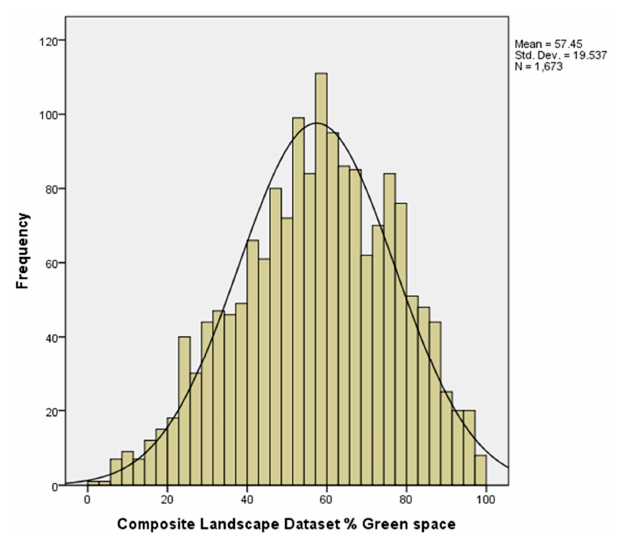
Figure 5. Frequency distribution of green space cover in local urban neighbourhoods. Top left, ( a ): Urban Atlas (EEA, 2012); Top right ( b ): Land Cover Map (Rowland et al. 2017) ; Bottom left ( c ): OS